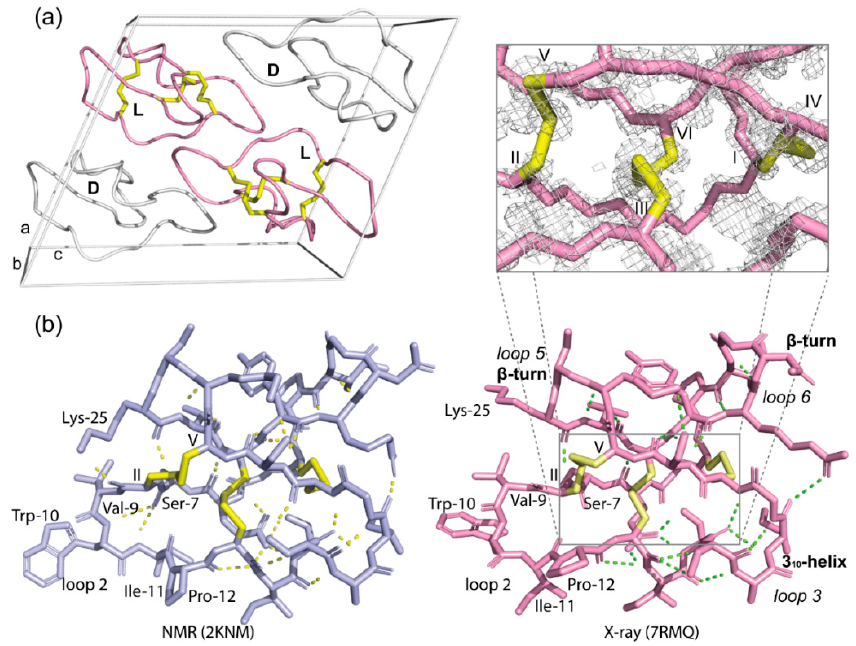
Figure 3. Quasi-racemic crystallography of cyO2. ( a ) Unit cell of quasi-racemate of wild-type cyO2 in space group P1 2 1 1. CyO2 is shown in pink and D -[I11L]cyO2 in white. ( b ) Comparison of cyO2 solution structure (light purple, PDB: 2KNM) and crystal structure (pink, PDB: 7RMQ). Yellow and green dashed lines represent the hydrogen bonds in the NMR and crystal structure, individually. Inset: 2Fo-Fc electron density map of the cystine knot shown at a σ level of 1.0.